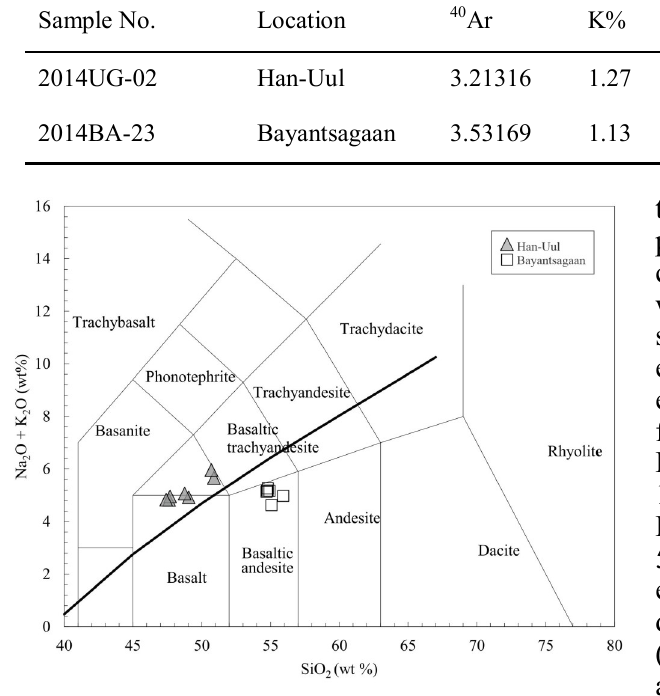
Fig. 4. Total alkalis (Na 1986) plot for analyzed samples from the Bayantsagaan and Han-Uul areas. Boundary line for alkaline and subalkaline series in figure (a) is from Irvine and Baragar